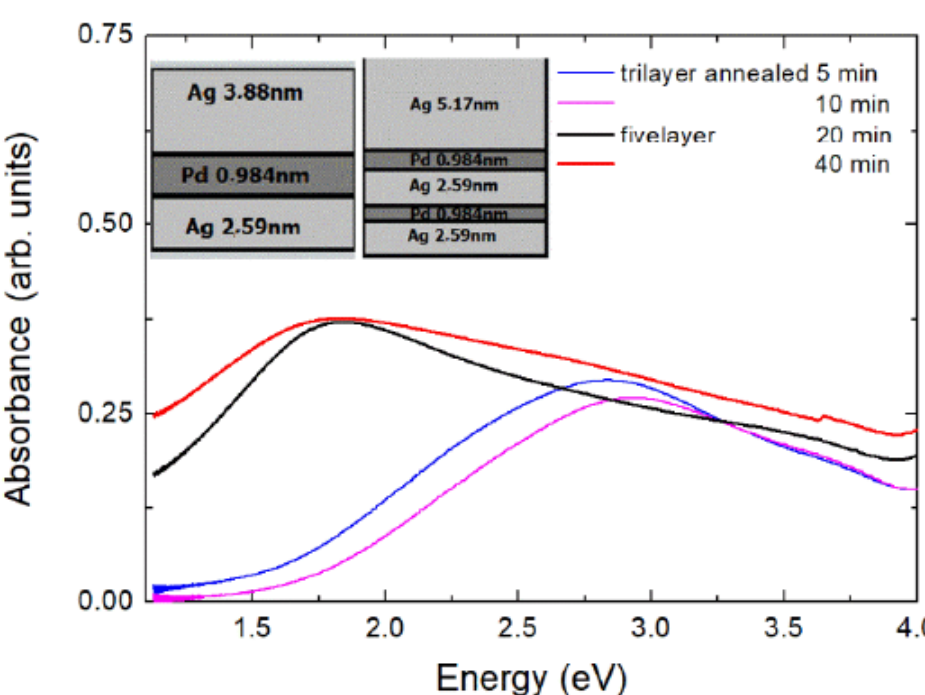
Figure 3. Absorbance spectra for thin Ag/Pd layered films on Corning glass annealed at 460 ◦ C in air. One may see broad LSPRs with a maximum at about the position of Ag NPs one, compared